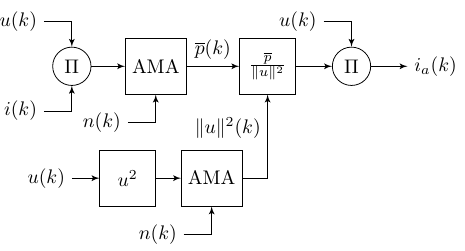
Figure 3. Block diagram representation of the CPT’s active measurements in the discrete time domain.